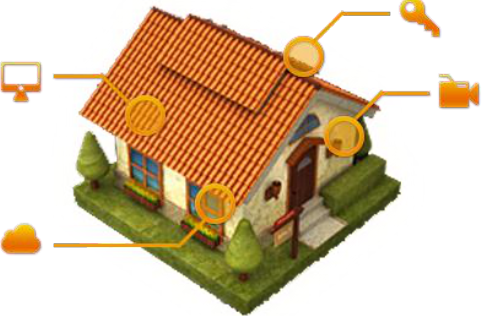
Figure 1. Integrated services in an AmI home environment. The integration process is responsible for the homogenization of heterogeneous systems, such as flood sensors with video